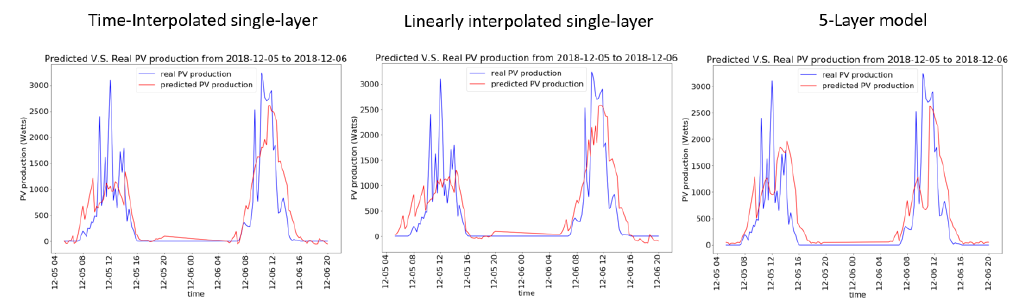
Figure 3. Examples of real vs. forecasted PV production for sunny days.